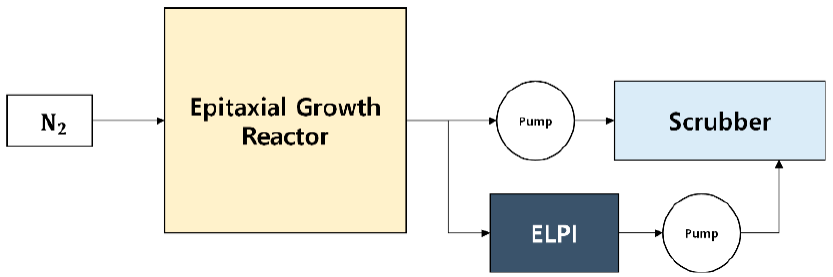
Figure 1. Schematic of the residual particle measurement setup during N 2 gas purge.